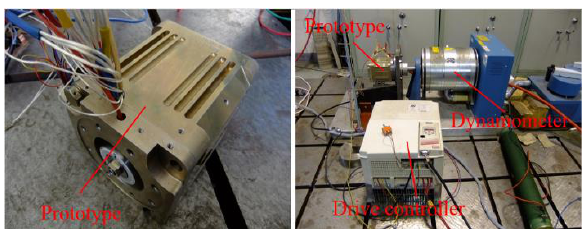
Figure 16. Experimental setup.